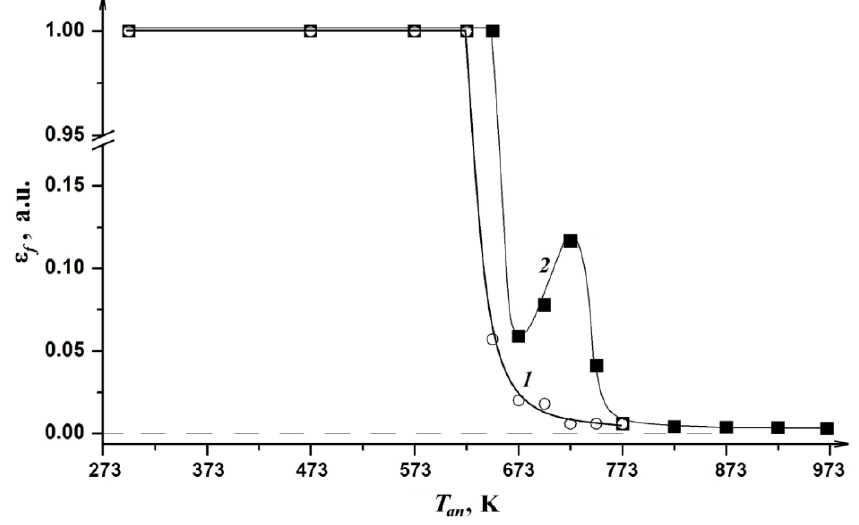
Figure 1. Effect of heat treatment on the plasticity ε f of AAs: 1 , Fe 53.3 Ni 26.5 B 20.2 ; 2 , Co 28.2 Fe 38.9 Cr 15.4 Si 0.3 B 17.2